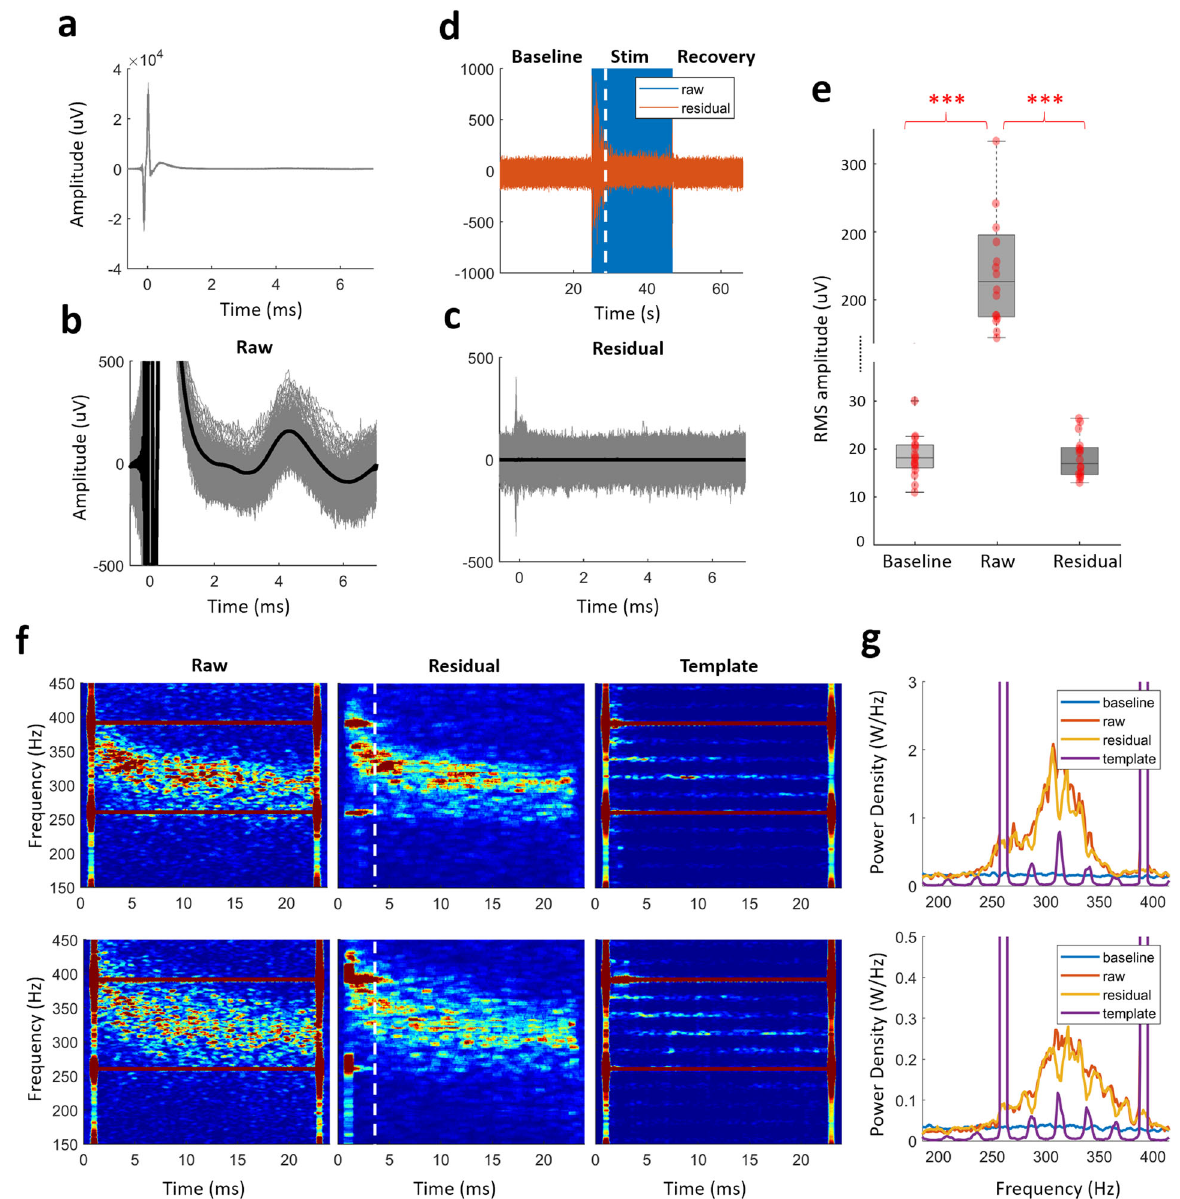
Fig. 4 HFO induced by therapeutic 130 Hz DBS is present even after removal of evoked waveform between stimulation pulses. a The overlay plot of raw data aligned with respect to the stimulus pulses (0.5 ms pre-onset was used to avoid edge artifacts). The large biphasic stimulation artifact at 0 ms masks both ECA and other LFP activity. b , c The same segment in a shown with 1 mV amplitude scale before and after denoising, to better demonstrate the removal of ECA waveform between pulses (thicker lines indicate the average waveform). The residual was obtained by subtraction of reconstructed segments from the raw data and it is devoid of stimulus pulse and inter-pulse evoked activity. d The amplitude range of the denoised (residual) data is similar to the baseline levels, except the fi rst 3 s seconds of transient period. This segment, denoted with the dashed lines, was removed from overlay plots for clarity and excluded from spectral plots as well. e The root-mean-square (RMS) amplitude of the baseline segment before stimulation as well as raw and residual traces during stimulation. There was no signi fi cant difference between baseline and the denoised stimulation segment ( n = 16). The fi rst 1 ms including the large stimulation artifact was omitted from the RMS calculations to capture the amplitude levels associated with the evoked response. f TFM of the raw and residual segments and the template trace that was removed, as well as g their PSD plots from two representative patients illustrate that the denoising primarily removes the artifacts at the sub-harmonics of stimulation frequency while keeping the enhanced HFO intact. The varying power levels of the sub-harmonics throughout the spectrum are due to the leakage from the background activity to the extracted template trace and do not affect the overall peak and power characteristics of the HFO activity when removed. The color scale of the TFMs is same as limits of y -axis of their corresponding PSD plots. The dashed lines on TFMs denote the transition artifacts associated with turning the stimulator on and off. On each box in the boxplots, the central mark indicates the median, and the bottom and top edges of the box indicate the 25th and 75th percentiles, respectively. The whiskers extend to the most extreme data points not considered outliers, and the outliers are plotted individually using the “ + ” symbol. The individual data points are also plotted as red circles. *** denotes signi fi cance